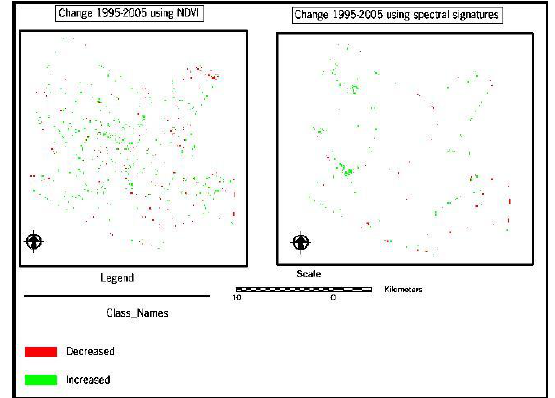
Figure 10: Changes by NDVI versus Changes by reflectance